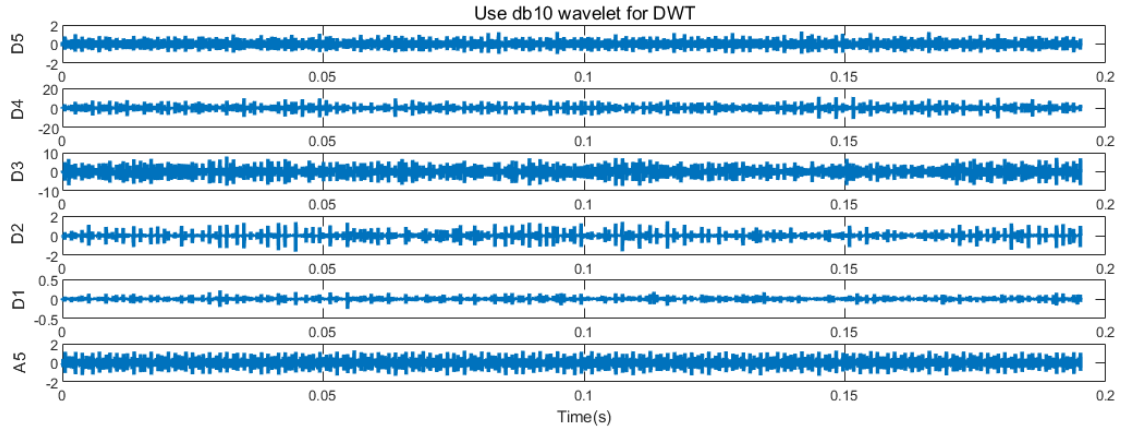
Figure 7. The waveform of the reconstructed signal.